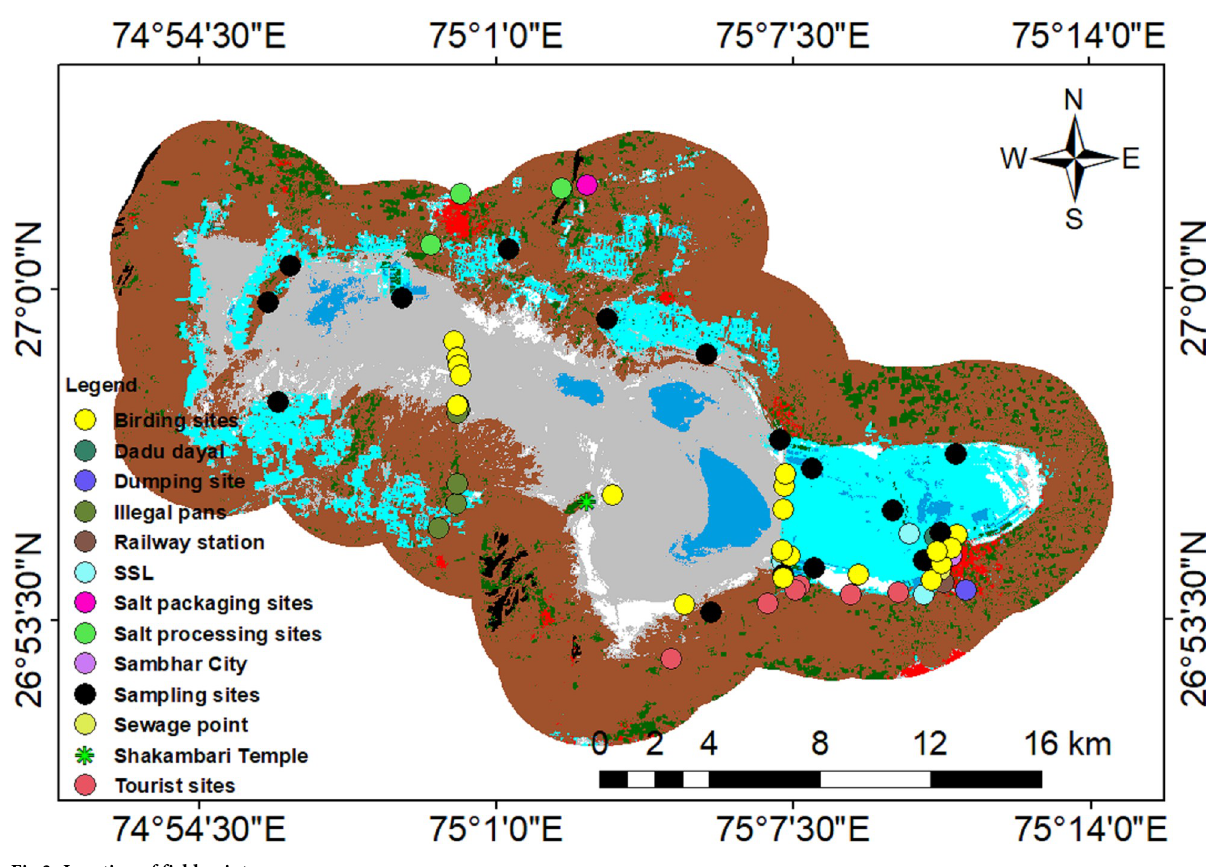
Fig 3. Location of field